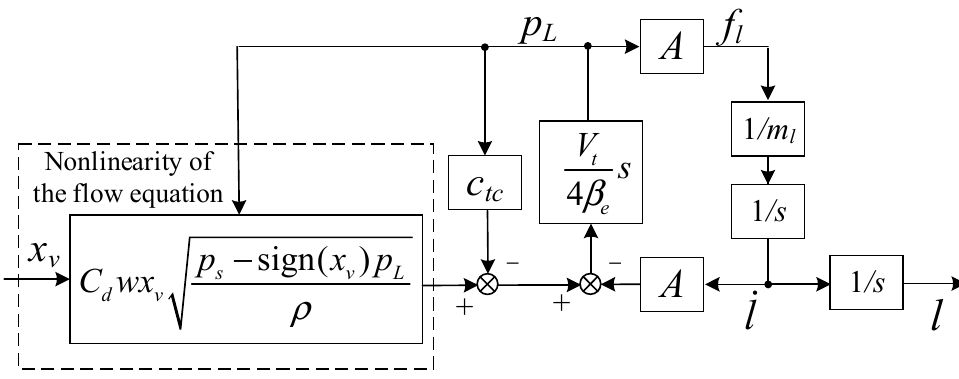
Figure 6. Nonlinear model of the electrohydraulic servo system.